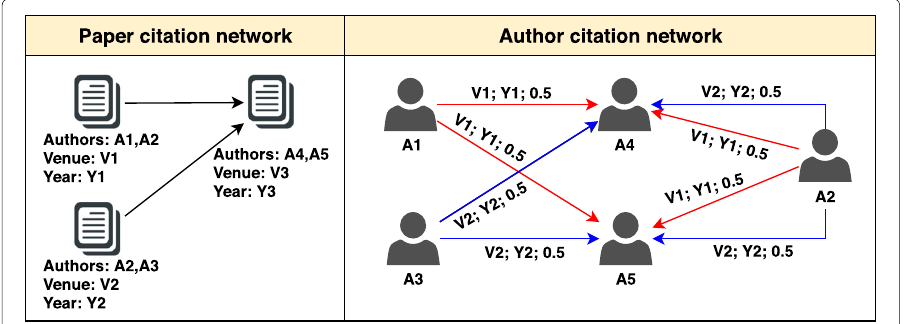
Fig. 1 Comparison of paper-level and author-level